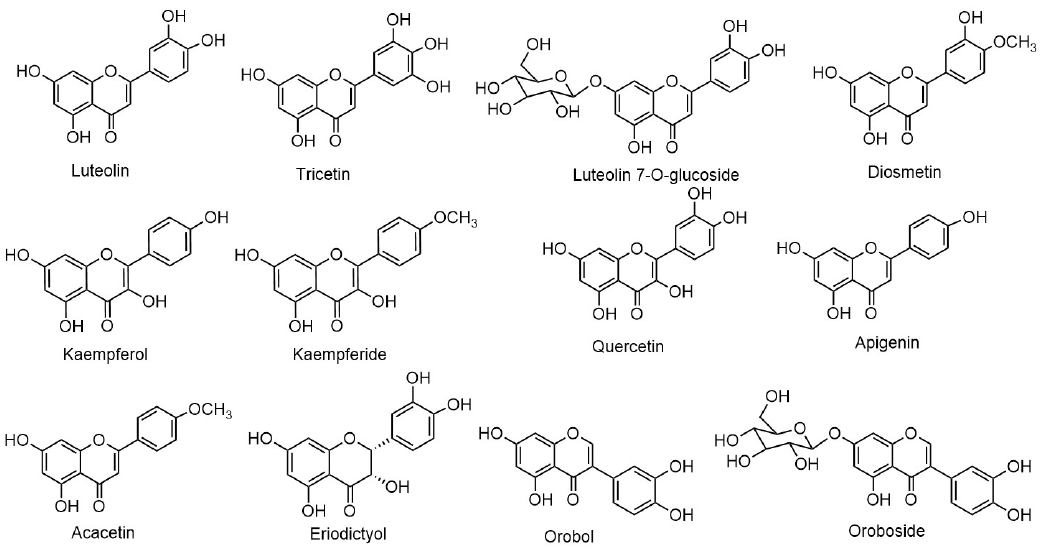
Figure 5. Structures of main flavonoids.